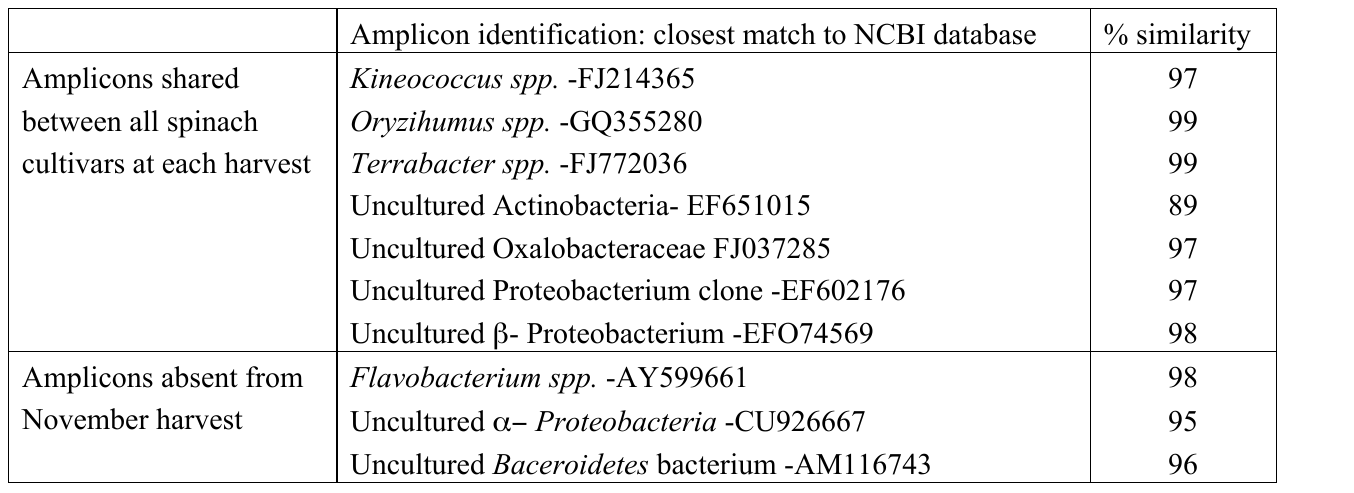
Table 5. Identification of common amplicons from all cultivars and bands absent from November